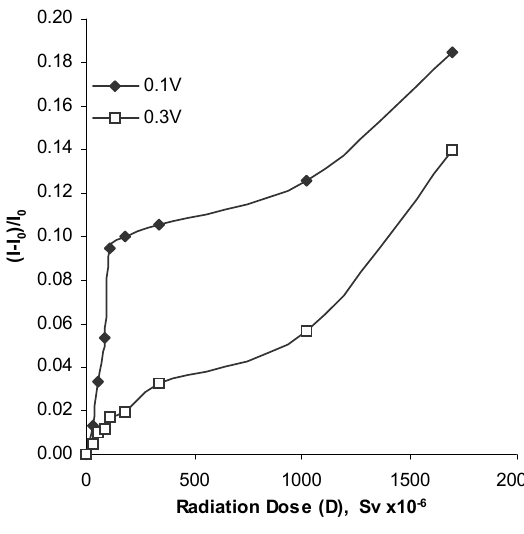
Figure 11. Plots of normalized current (I-I and 0.3 V for 0.2 wt.% Carbon-filled NiO planar